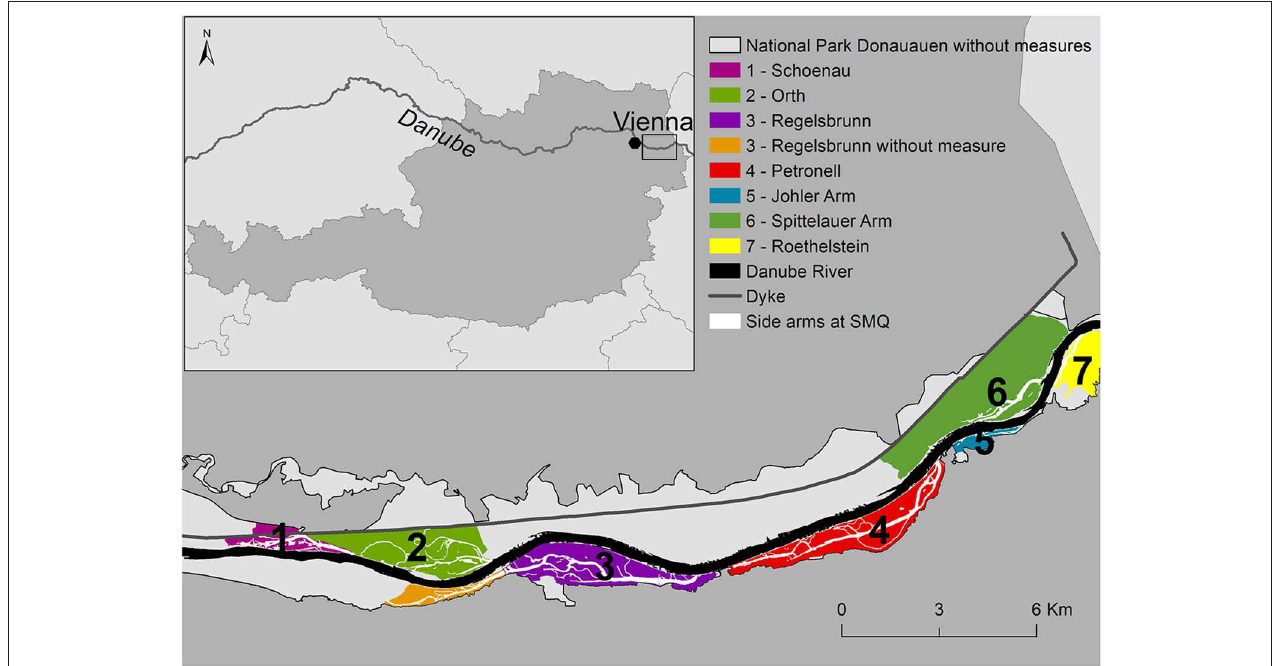
FIGURE 1 | Location of study site with the seven side-arm systems along the Danube River in Austria.